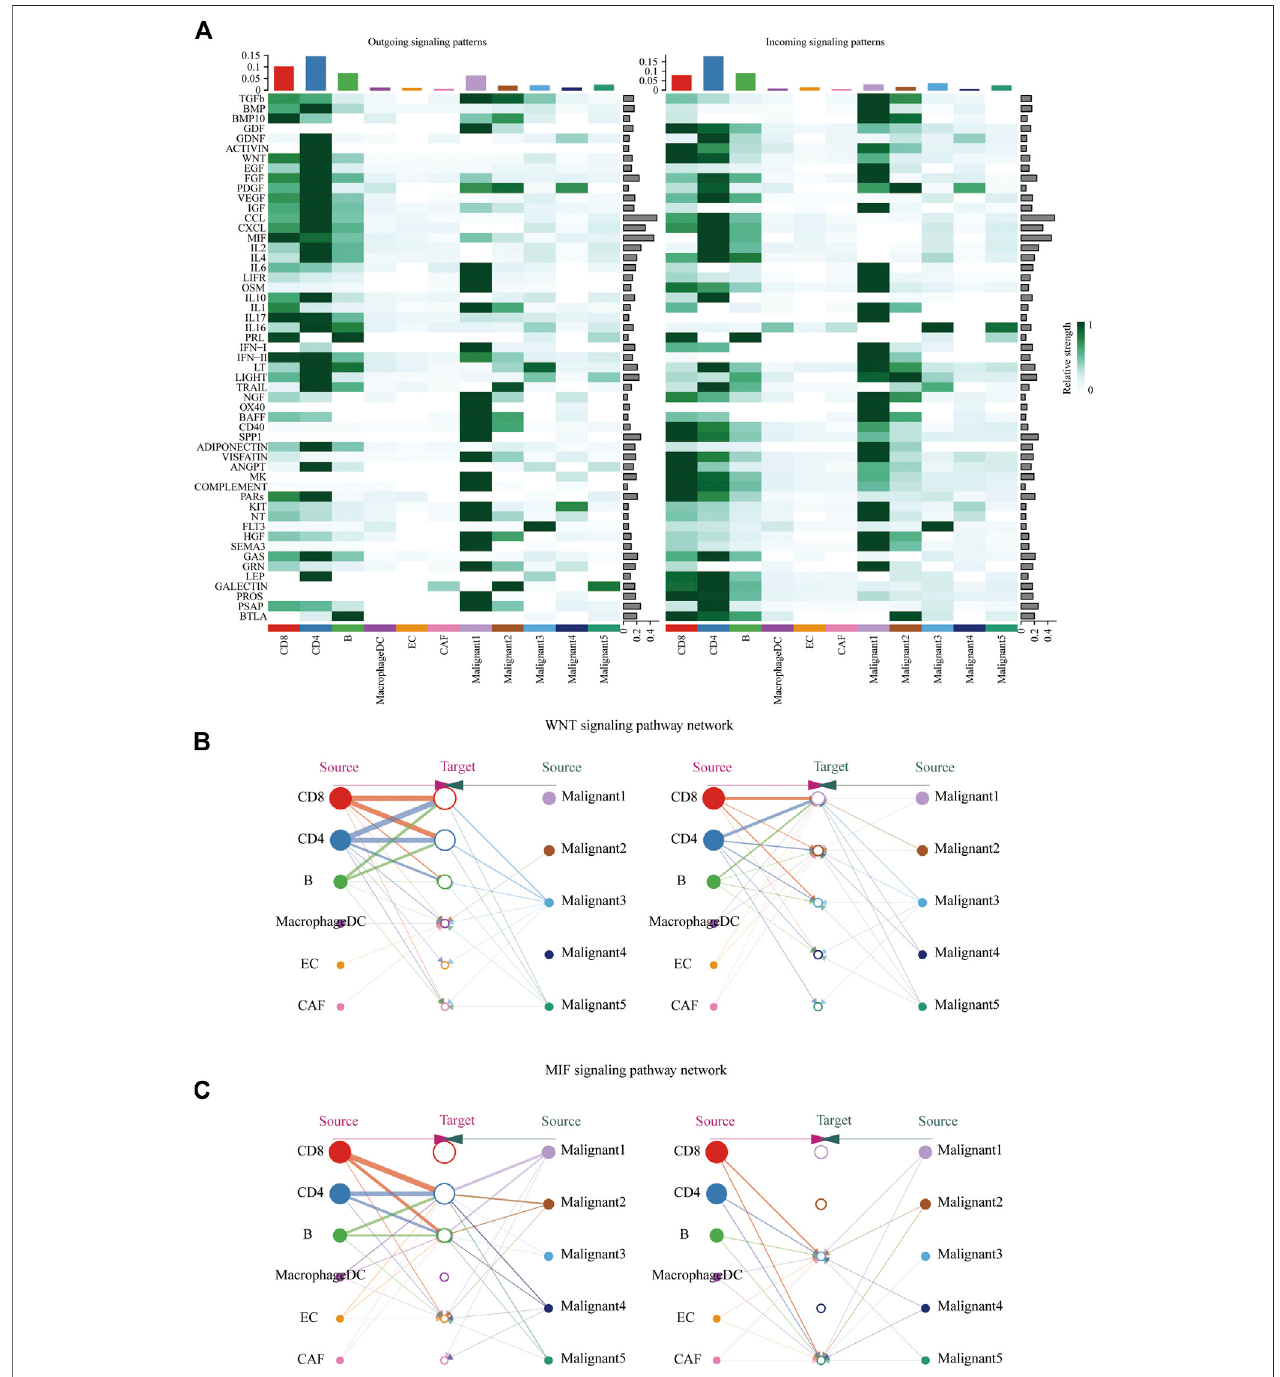
FIGURE 5 | Identi fi cation of major signaling changes in melanoma. (A) Heatmap shows outgoing (Left) and ingoing (Right) signaling patterns. (B,C) Hierarchical diagram shows the inferred cell-cell communication network of WNT signaling (B) and MIF signaling (C) . Edge thickness indicates the weight of signals between